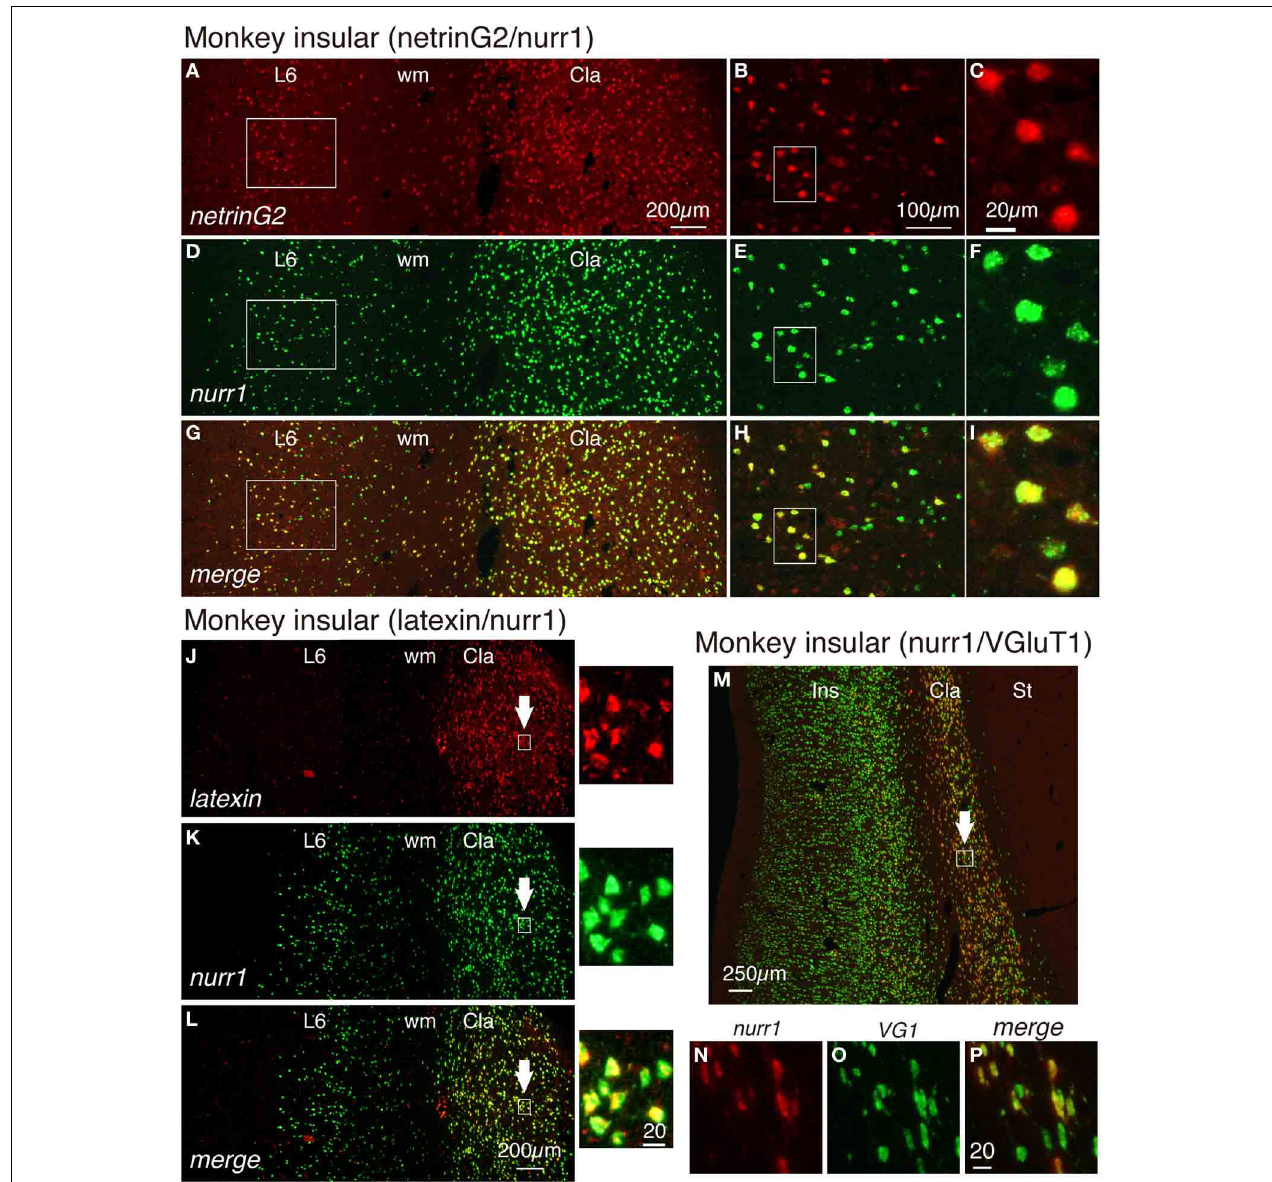
FIGURE 4 | Gene expression profiling for insular and claustral neurons by netrin G2, nurr1, latexin, and VGluT1 genes. (A,D,G) Double ISH of netrinG2 (red) and nurr1 (green) mRNAs in the monkey brain section that spans layer 6 (L6) of the insular cortex and the claustrum (Cla). Left side is to the pia matter. Red (A) , green (D) , and merged (G) channels were shown for the same section to demonstrate the colocalization of netrinG2 and nurr1 mRNA signals. (B,E,H) Rectangles in (A,D,G) were magnified. (C,F,I) Rectangles in (B,E,H) were magnified. (J–L) Double ISH of latexin (red) and nurr1 (green) mRNAs in the monkey brain section that spans layer 6 (L6) of the insular cortex and the claustrum (Cla). Left side is to the pia matter. The